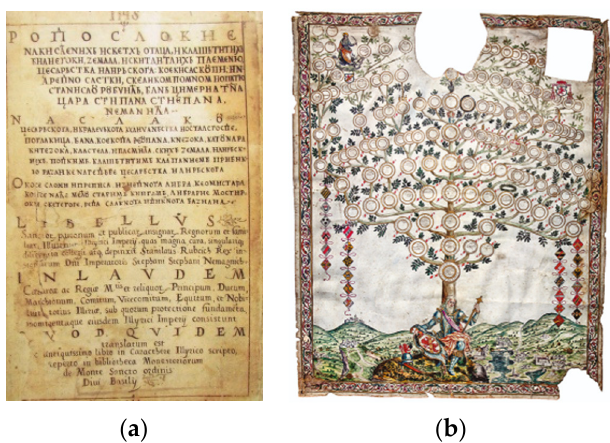
Figure 2. ( a ) The first page of the Korenich-Neoric armorial. ( b ) The Korenich-Neoric genealogical family tree.